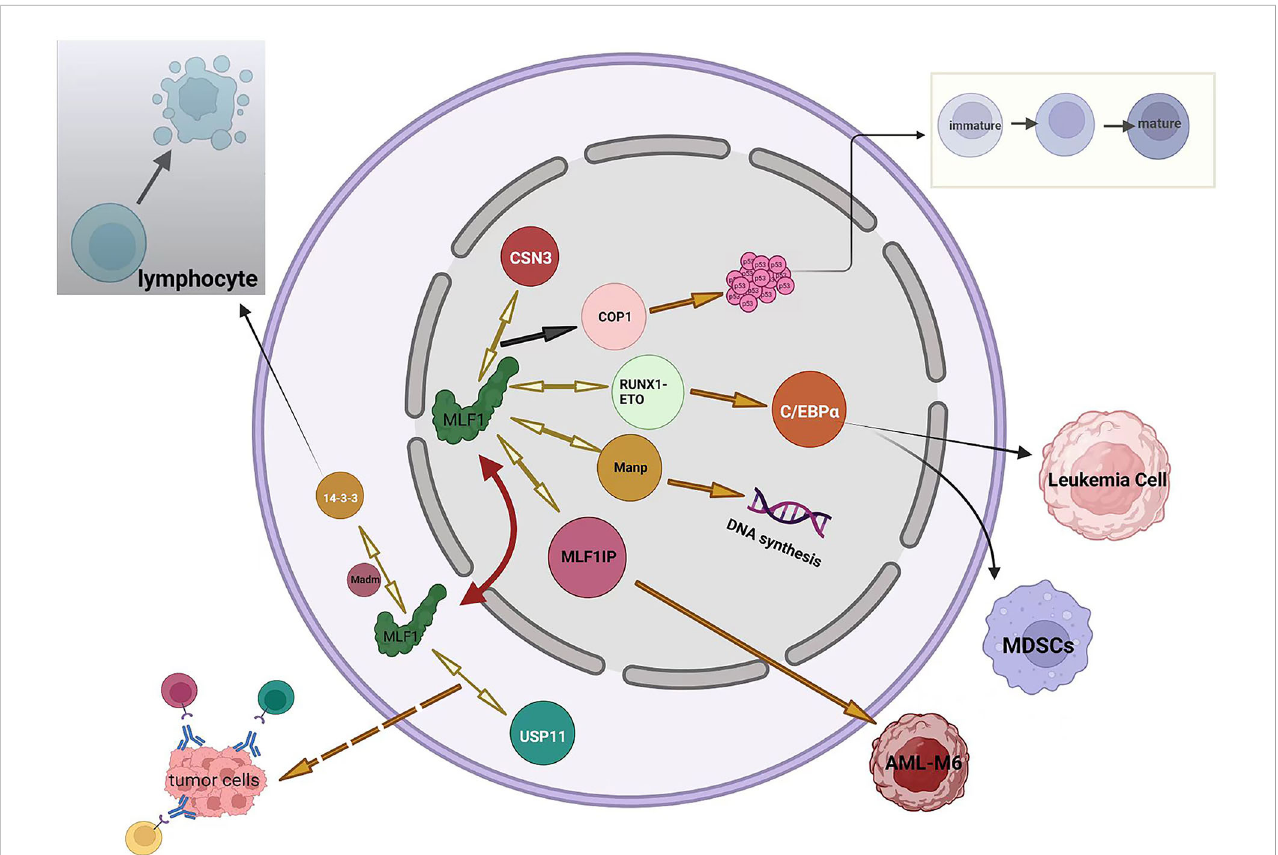
FIGURE 2 Summary of MLF1 networks. Black arrows represent negative regulation (including inhibition or downregulation), orange arrows represent positive regulation (including promotion or upregulation), orange dotted arrow represents speculation, and bidirectional yellow arrows indicate proteins interacting with MLF1 protein. The red two-way arrow illustrates the shuttling of MLF1 between the nucleus and the